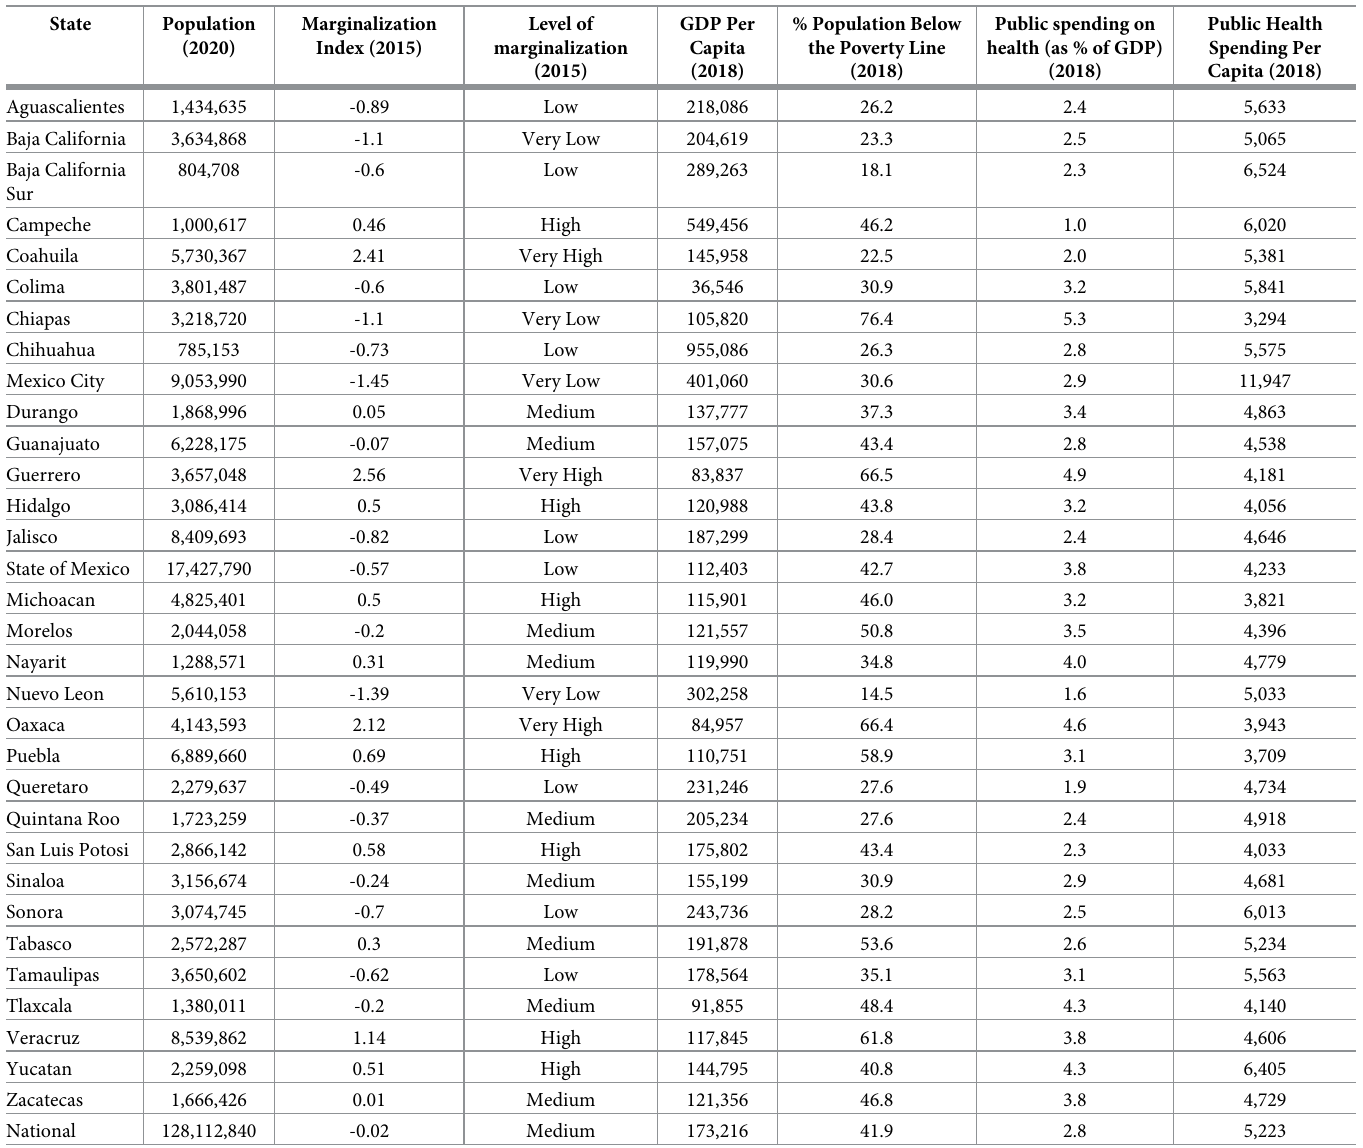
Table 2. Main sociodemographic statistics by state.